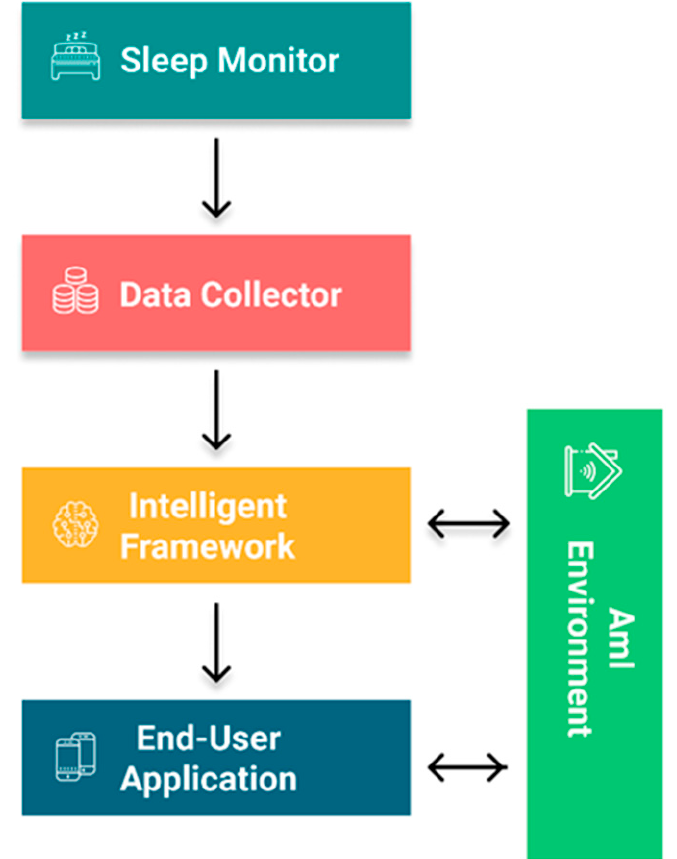
Figure 12. High-level system architecture.